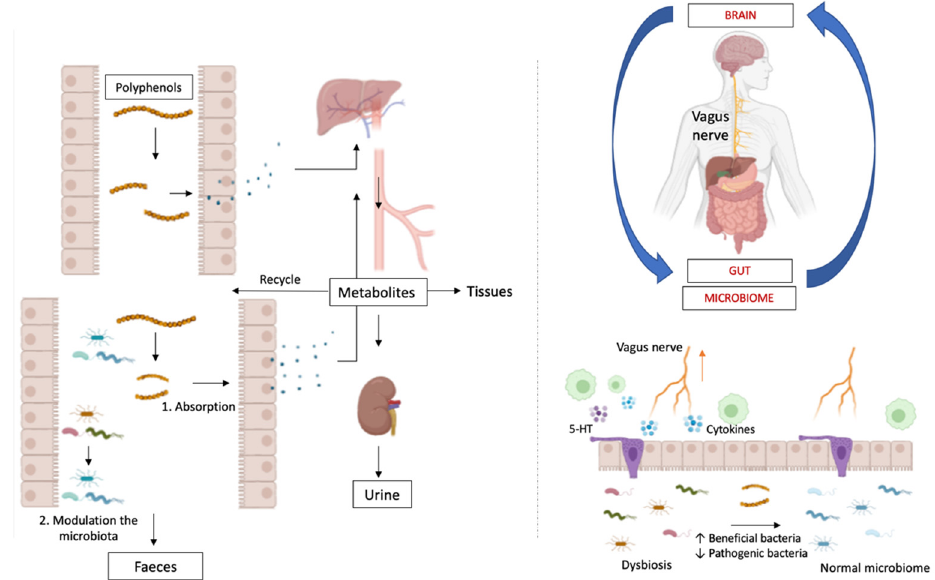
Figure 5. Once the polyphenols are ingested, a minimal part is metabolized in the small intestine and the majority in the large intestine. These are absorbed and passed to the liver, from where they can return to the intestine, be eliminated in the urine, or be distributed to different tissues or organs. In case of dysbiosis, polyphenols can help promote normal microbiota, thus reducing inflammatory mechanisms and sensitization of vagus nerve